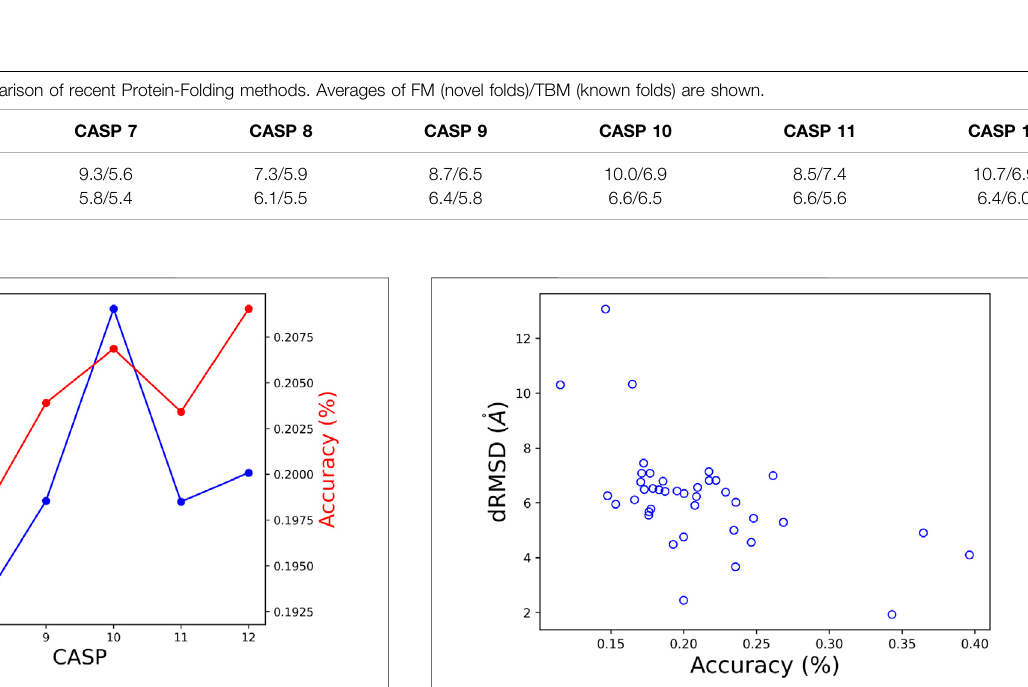
FIGURE 6 | The obtained dRMSD and residue accuracy on the union of test of subsequent CASP editions. (e.g., the test set for CASP 8 is a union of CASP 8 until 12).